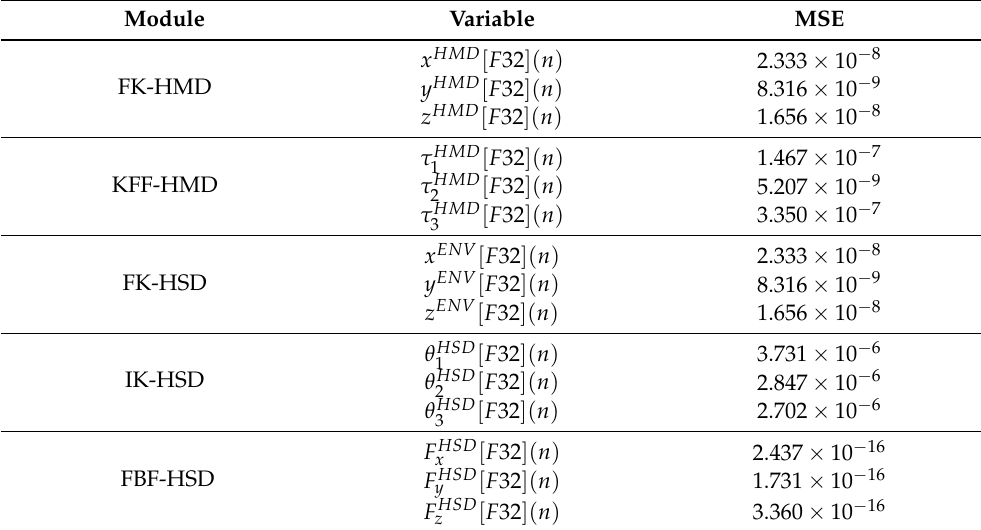
Table 1. Mean squared error (MSE) results for floating-point